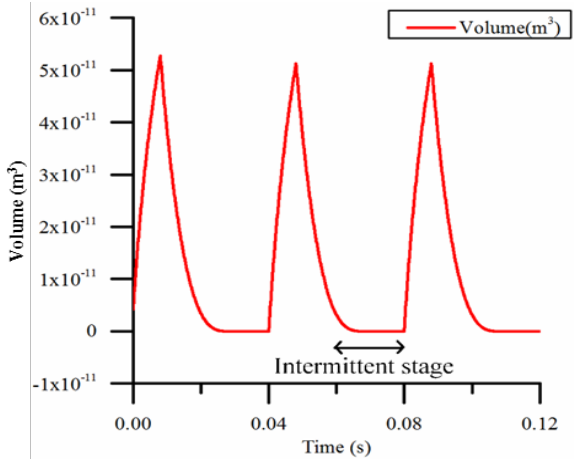
Figure 10. The volume of bubble calculated by the model when the duty cycle is 20% and the heating frequency is 25 Hz.